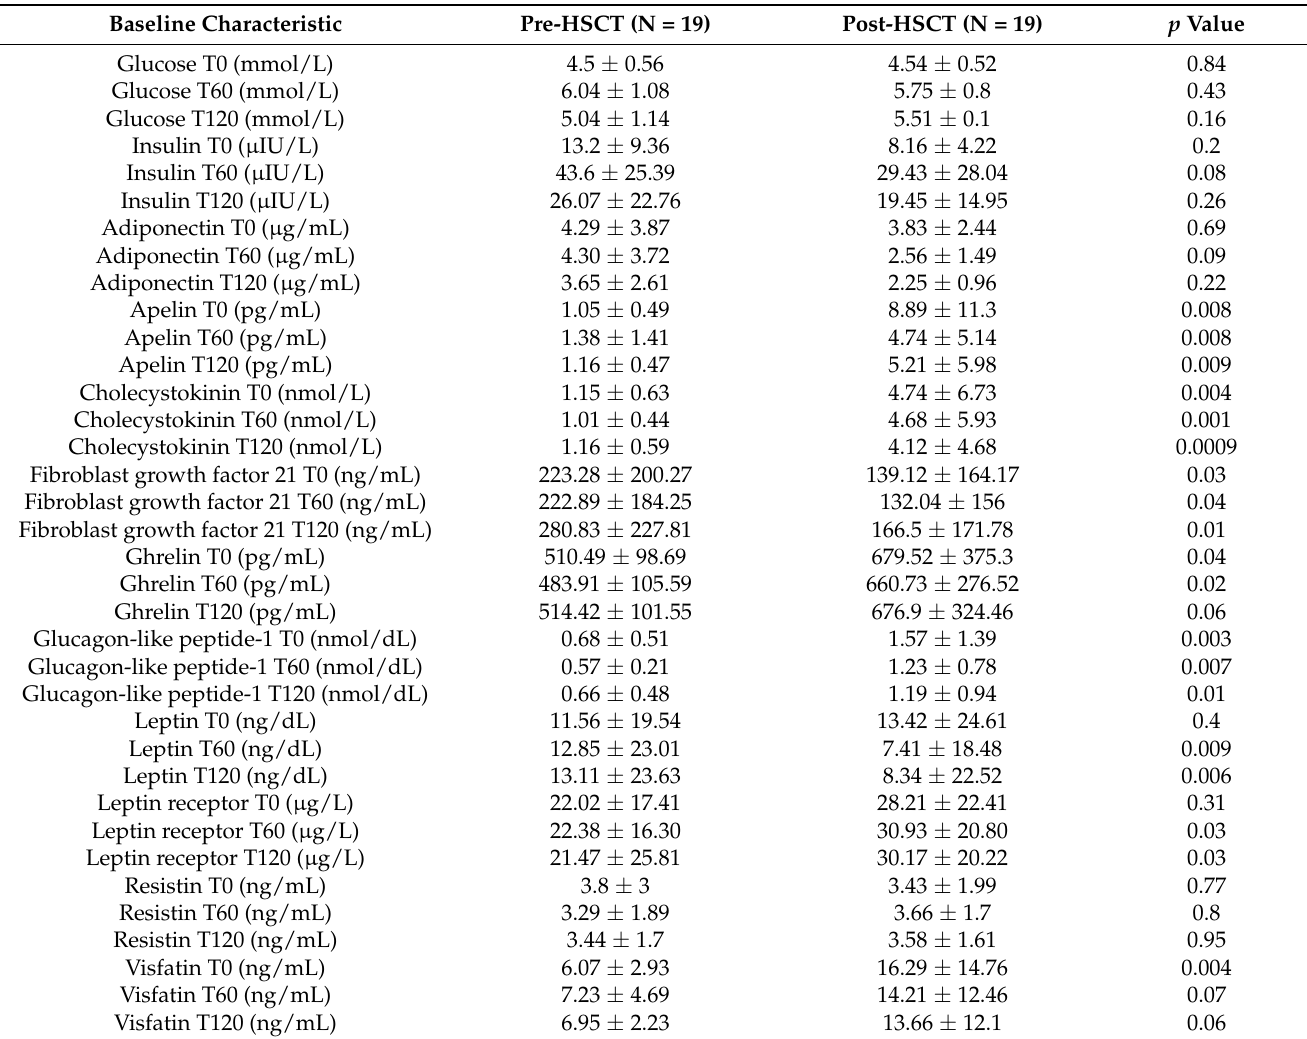
Table 2. Biochemical parameters of the study group (mean ± standard